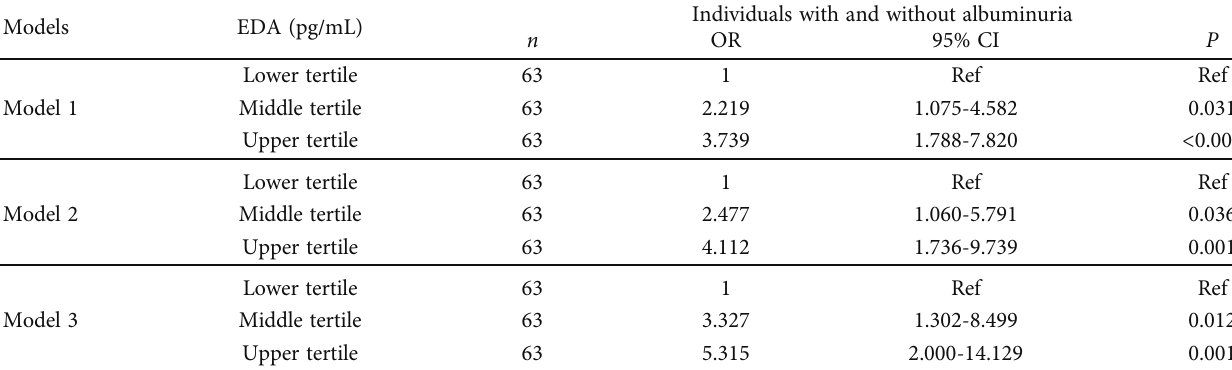
Table 6: OR and 95% CI for albuminuria by the tertiles of ectodysplasin A in T2DM. Models